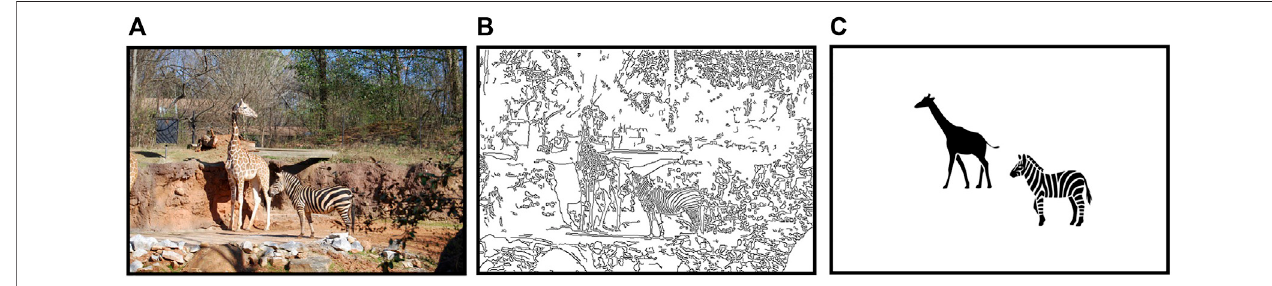
FIGURE 1 | Which photographic representation is easier to read into? The fi gure shows a panel of images with a photograph of animals in the (A) , an edge map of the same image in the (B) , and icons representing only the two animals in the (C)